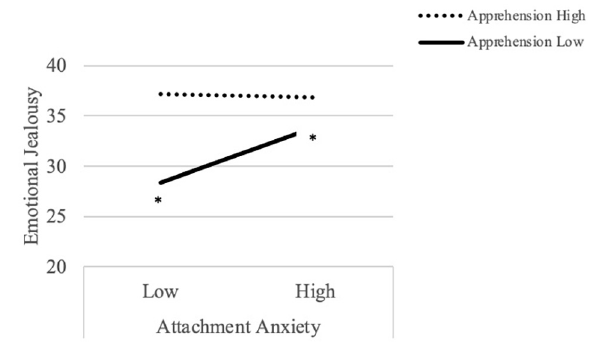
FIGURE 1 | Attachment style and concern about misunderstandings interact to predict cognitive/behavioral jealousy.